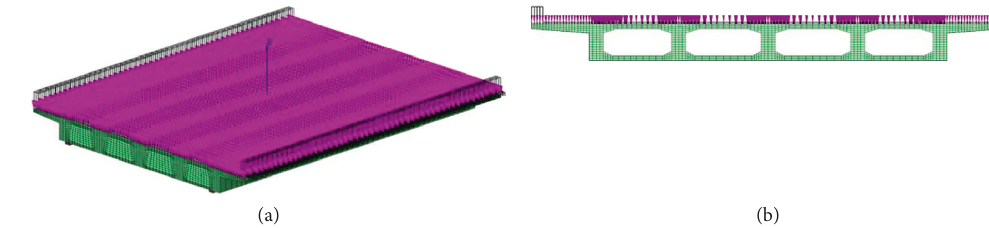
Figure 1: (a) 3D FE model and action. (b) Section of the girder.